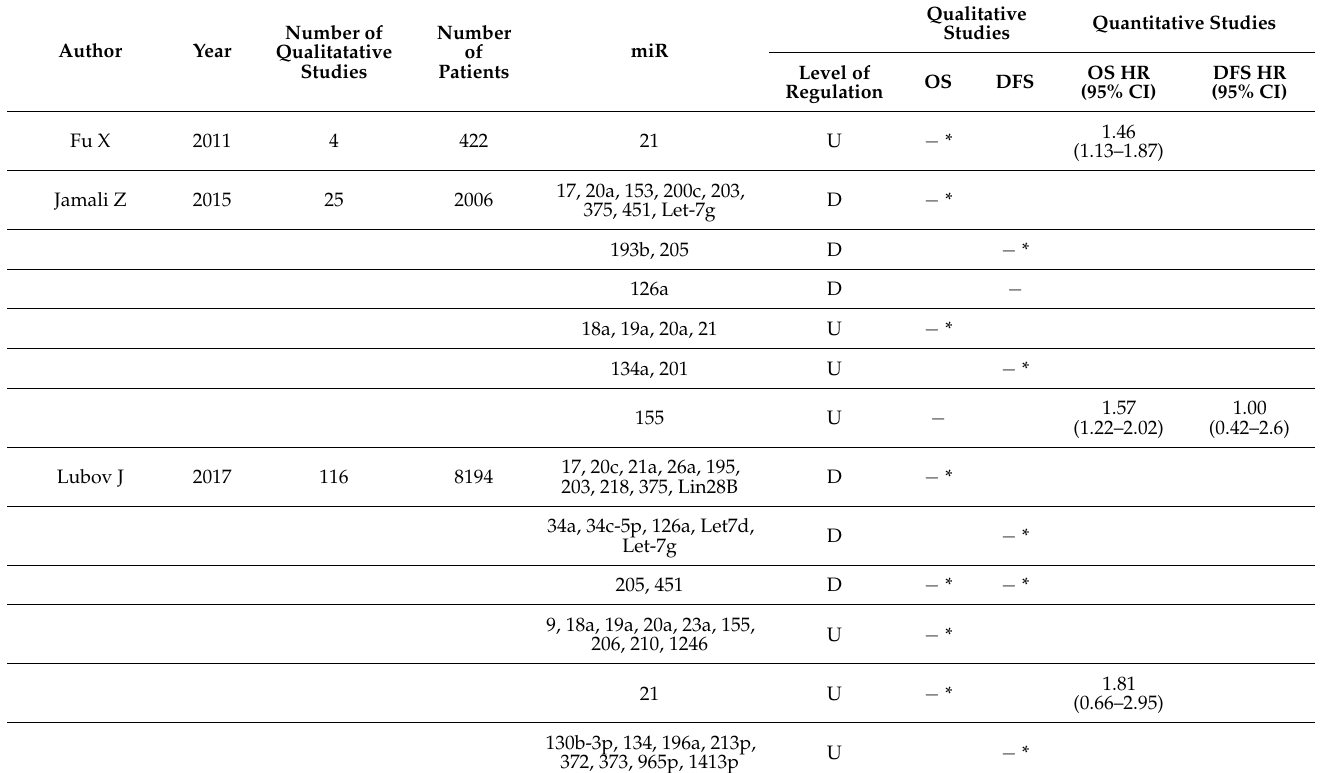
Table 2. Characteristics and main findings of the six systematic reviews and meta-analysis